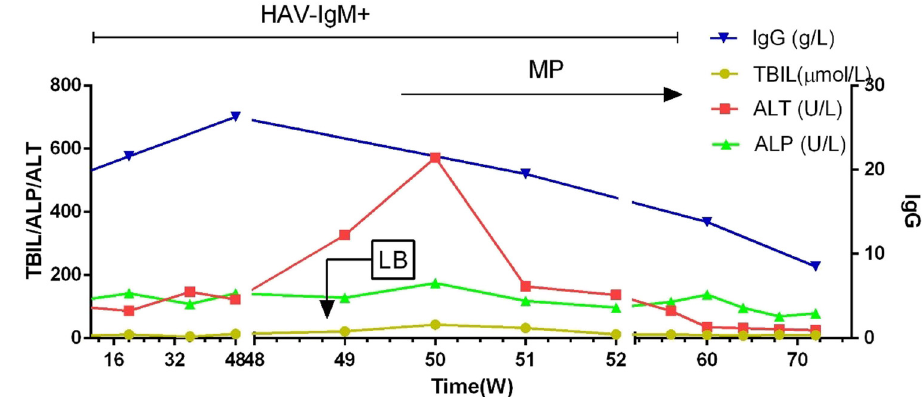
Figure 1: Changes in the liver function and immunological indexes ( LB: liver biopsy; MP: methyl prednisolone ) .